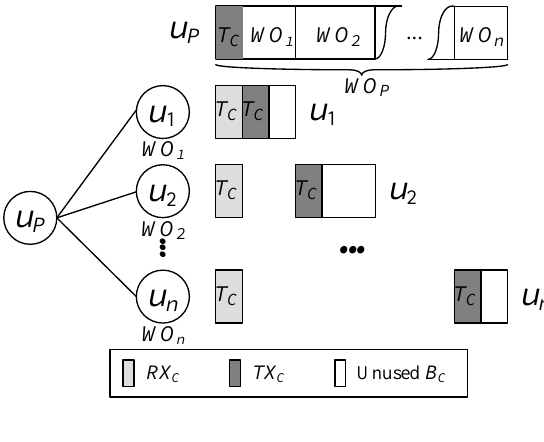
Figure 2. Scheduling for the control